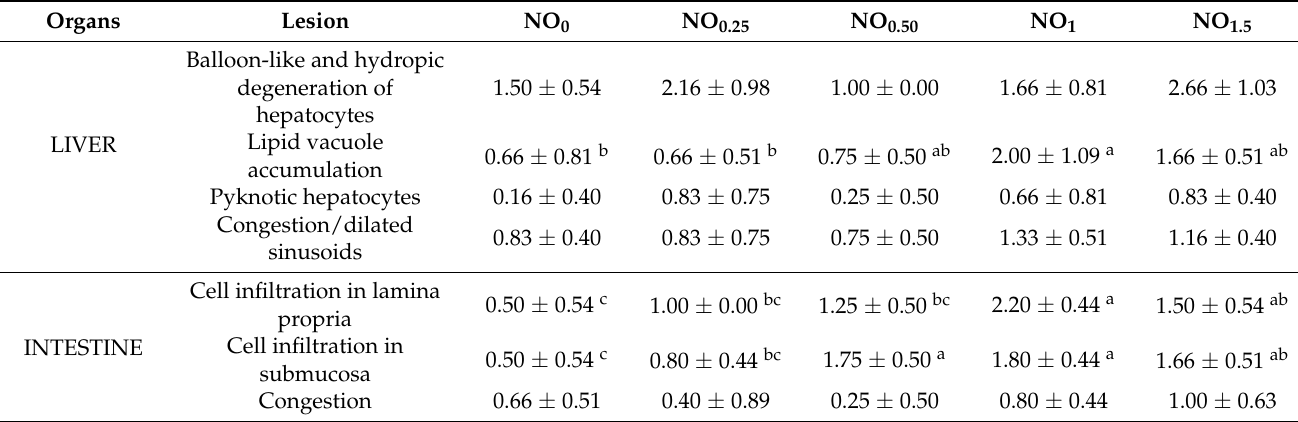
Table 5. Histopathological observation on liver and intestine of common carp fed for 60 days with experimental diets supplemented with different percentages of neroli oil